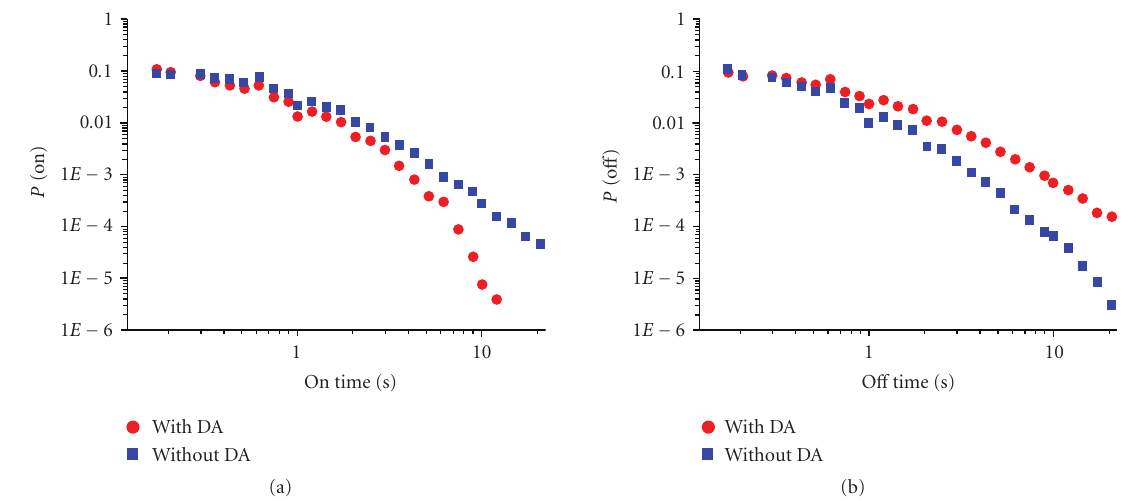
Figure 7: Probability histograms for (a) on-times and (a) o ff -times durations with (red) and without (blue) dopamine conjugated to the QD surface. A strong e ff ect of dopamine in both on-times and o ff -times durations is evident. The addition of dopamine reduces the probability of observing long on-times and increases the probability of observing long o ff